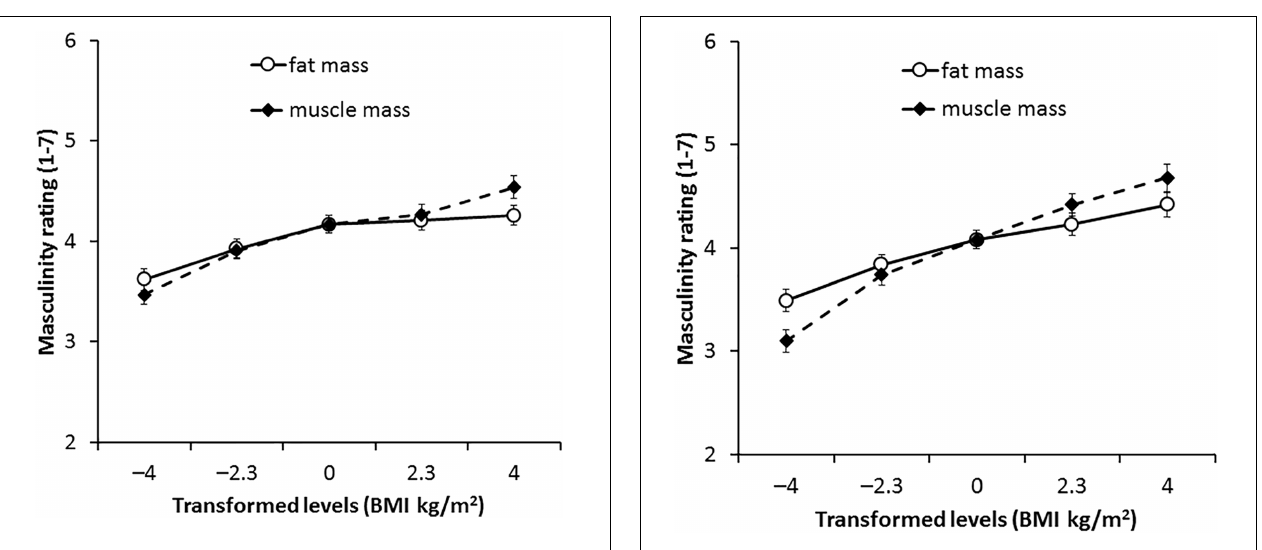
FIGURE 5 | Average masculinity ratings for faces transformed with the face shape correlates of fat and muscle mass for the 2D version of 3D face set. Error bars represent the standard